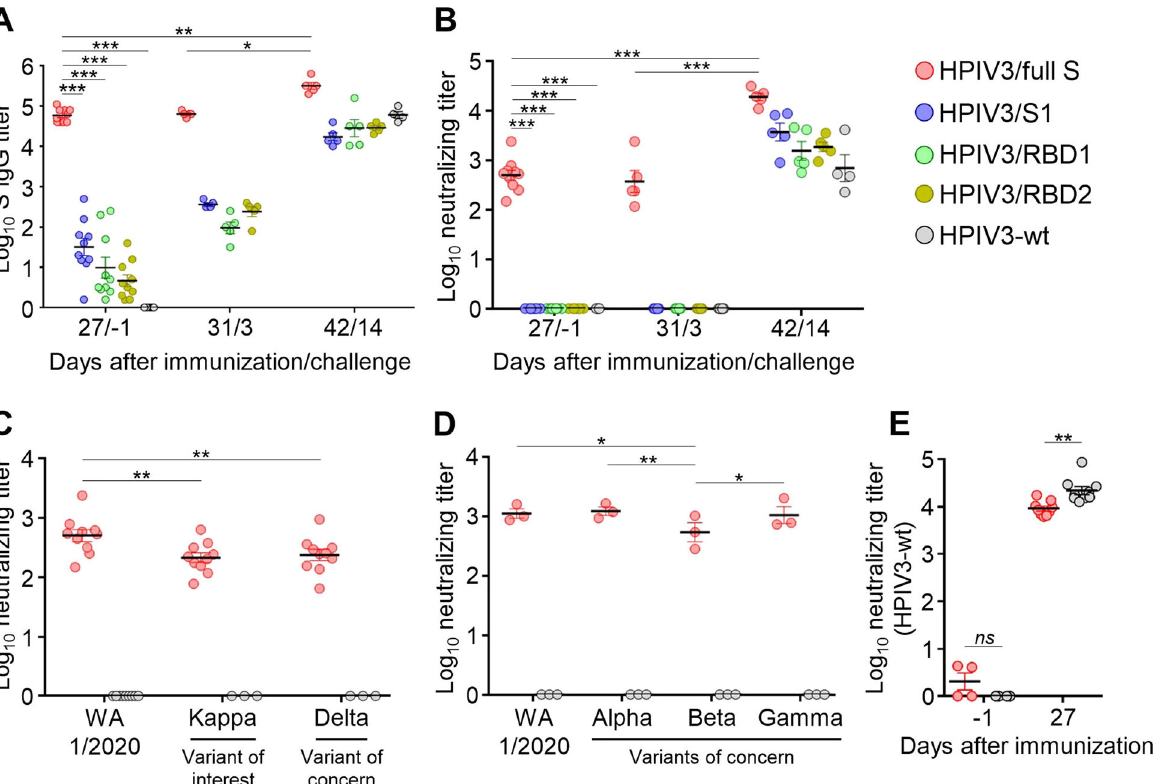
Fig. 2 Full S vaccine elicits antibodies neutralizing SARS-CoV-2 and its genetic variants. A Total serum titers of SARS-CoV-2 S-speci fi c IgG measured by ELISA. OD values from pre-bleed serum samples were subtracted from that of the test controls, and titers were determined using a four-parameter logistic curve fi t. B Serum neutralization of mNeonGreen-expressing SARS-CoV-2 (WA1/2020) measured by high-throughput screening (HTS). C Serum neutralization of mNeonGreen-expressing SARS-CoV-2 (Kappa and Delta variants) on day 27 post-immunization, HTS format. Neutralization data for WA1/2020 are taken from panel B for comparison. D Serum neutralization of SARS-CoV-2 biological isolates on day 27 post-immunization measured by a standard plaque reduction neutralization assay. E Serum neutralization of HPIV3-wt (plaque reduction assay). Data represent mean ± SEM based on n = 3 – 10. * p < 0.05; ** p < 0.01; *** p < 0.0001 (two-way ANOVA with multiple comparisons, Fisher ’ s LSD test). Ns not signi fi